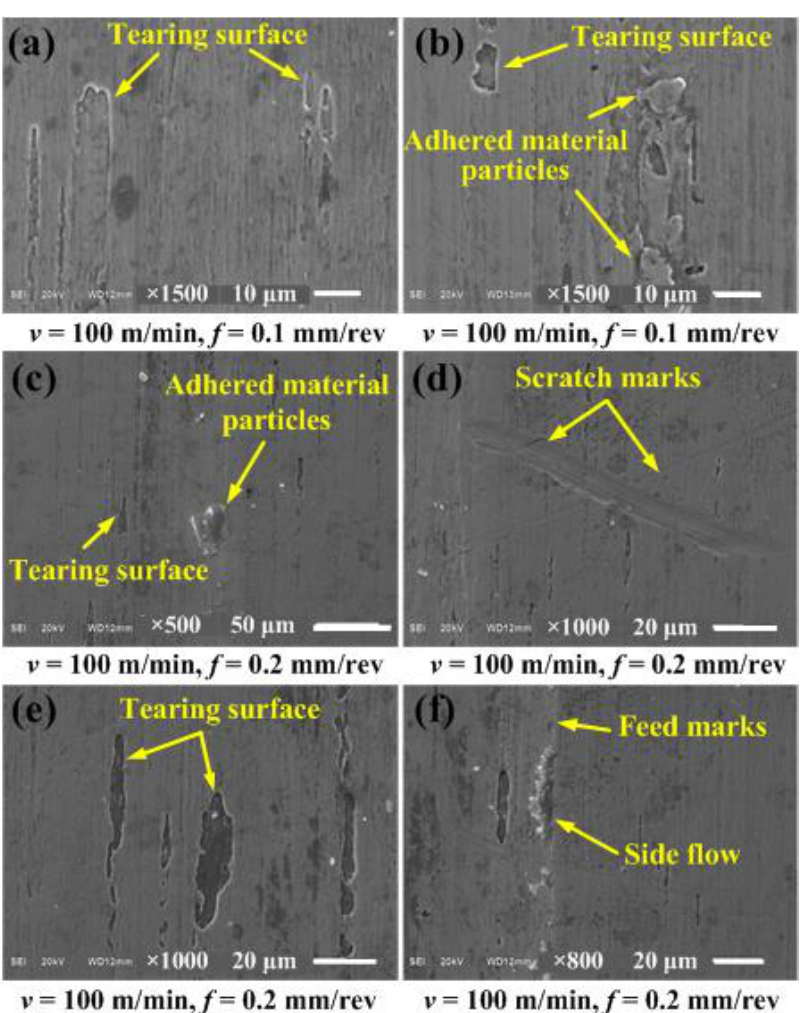
Figure 4. Surface defects of turned cylinder surfaces, ( a ) v = 100 m/min, f = 0.1 mm/rev; ( b ) v = 100 m/min, f = 0.1 mm/rev; ( c ) v = 100 m/min, f = 0.2 mm/rev; ( d ) v = 100 m/min, f = 0.2 mm/rev; ( e ) v = 100 m/min, f = 0.2 mm/rev; ( f ) v = 100 m/min, f = 0.2 mm/rev.